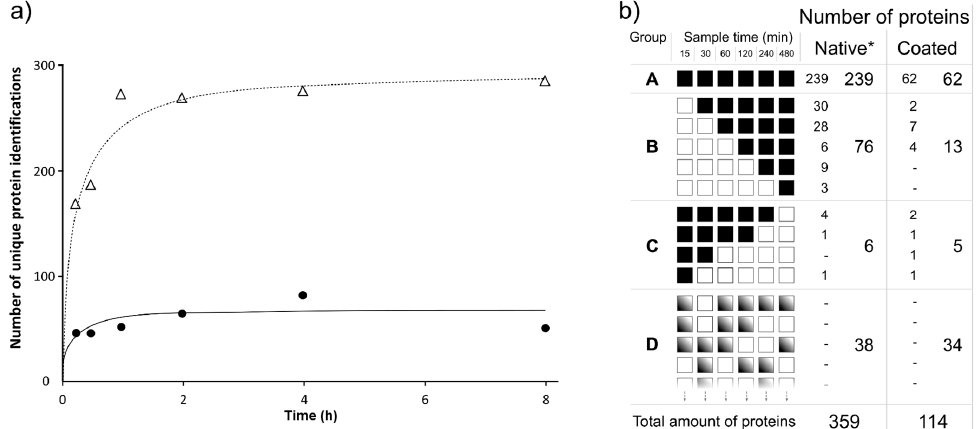
Figure 2. Time dependent protein adsorption. ( a ) Total number of adsorbed proteins as function of time. The total number of adsorbed proteins at each time point, detected with at least two unique peptides, plotted against time of adsorption. Triangles represent native membranes and filled circles represent coated surfaces; ( b ) A schematic heat map and distribution chart of the identified proteins adsorbed onto native and modified membranes. In Group A, proteins are detected at all time points; in Group B, proteins are found after some time of incubation and at all following time points; in Group C, proteins show a pattern of being initially adsorbed and then desorption starts; and finally in Group D, proteins do not have any clear time dependent adsorption pattern. Protein identifications in the respective groups are presented in Supplementary File 1. * Proteins adsorbed to native membranes are in detail discussed by Undin et al. [7].